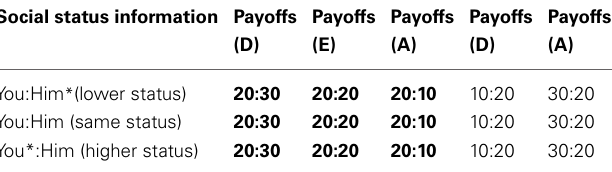
Table 1 | Payoff allocations in EUR.